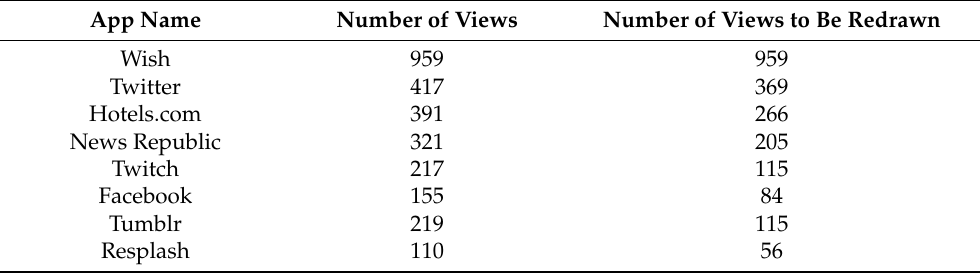
Table 1. Number of views in a window and number of views to be redrawn in a scrolling